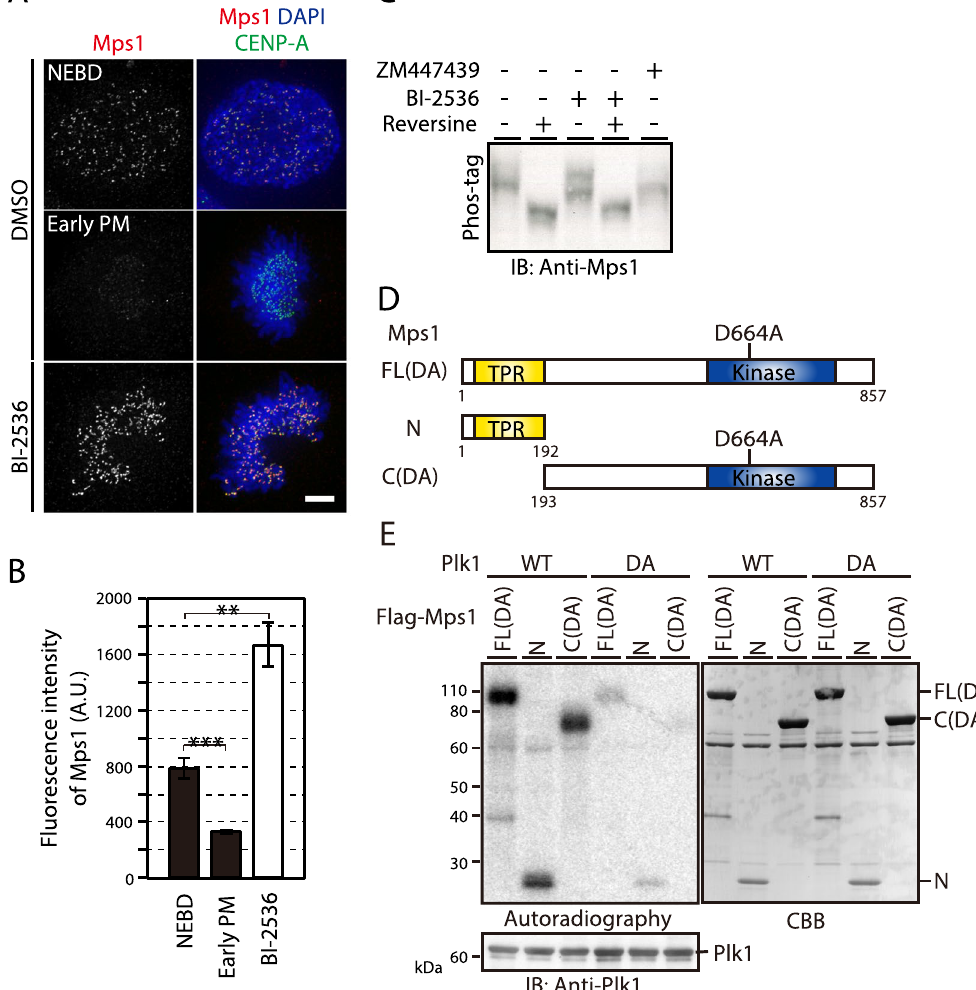
Figure 1. Plk1 phosphorylates Mps1 and affects its kinetochore localization. ( A ) Kinetochore localization of Mps1 in Plk1-inhibited cells. Mitotic HeLa cells expressing CENP-A-GFP (green) during nuclear envelope breakdown (NEBD) and in early prometaphase (PM), as well as in the presence of BI-2536, were fixed and immunostained with an antibody against Mps1 (red) and counterstained with 4,6-diamidino-2-phenylindole (DAPI) to label DNA (blue). Scale bar: 5 μ m. ( B ) Kinetochore Mps1 levels during NEBD, in early PM, and in the presence of BI-2536 were quantified. At least 91 kinetochores per cell (5 cells) were counted for each condition. The experiments were repeated three times, and the representative data obtained from a single experiment were shown. A.U: arbitrary units. Error bars represent S.E. ** P < 0.001; *** P < 0.0005 (two-tailed t -test). ( C ) Bandshift of Mps1 in cells treated with reversine (500 nM), BI-2536 (300 nM), or ZM447439 (2 μ M). Samples were subjected to Phos-tag SDS-PAGE followed by western blotting analysis using an antibody against Mps1. ( D ) Schematic representation of Mps1 truncation mutants used in the in vitro kinase assay. The locations of the tetratricopeptide repeat (TPR) domain, kinase domain, and the kinase-inactivating mutation are shown. ( E ) In vitro kinase assay of Mps1 by Plk1. The Mps1 truncation mutants shown in ( D ) were incubated with wild-type (WT) or kinase-dead (DA) Plk1 in the presence of γ - 32 P-ATP. γ - 32 P-ATP incorporated into the Mps1 constructs was detected by